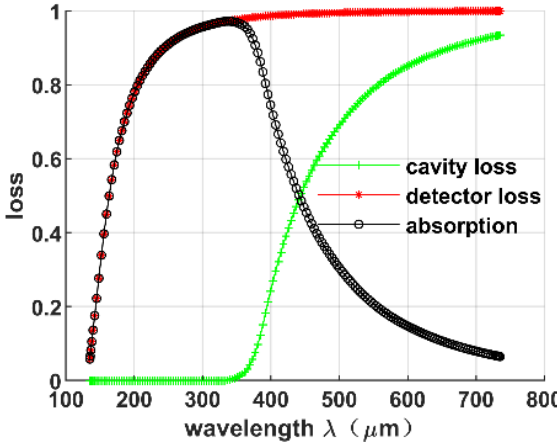
Figure 3. Energy loss and absorption coefficient.